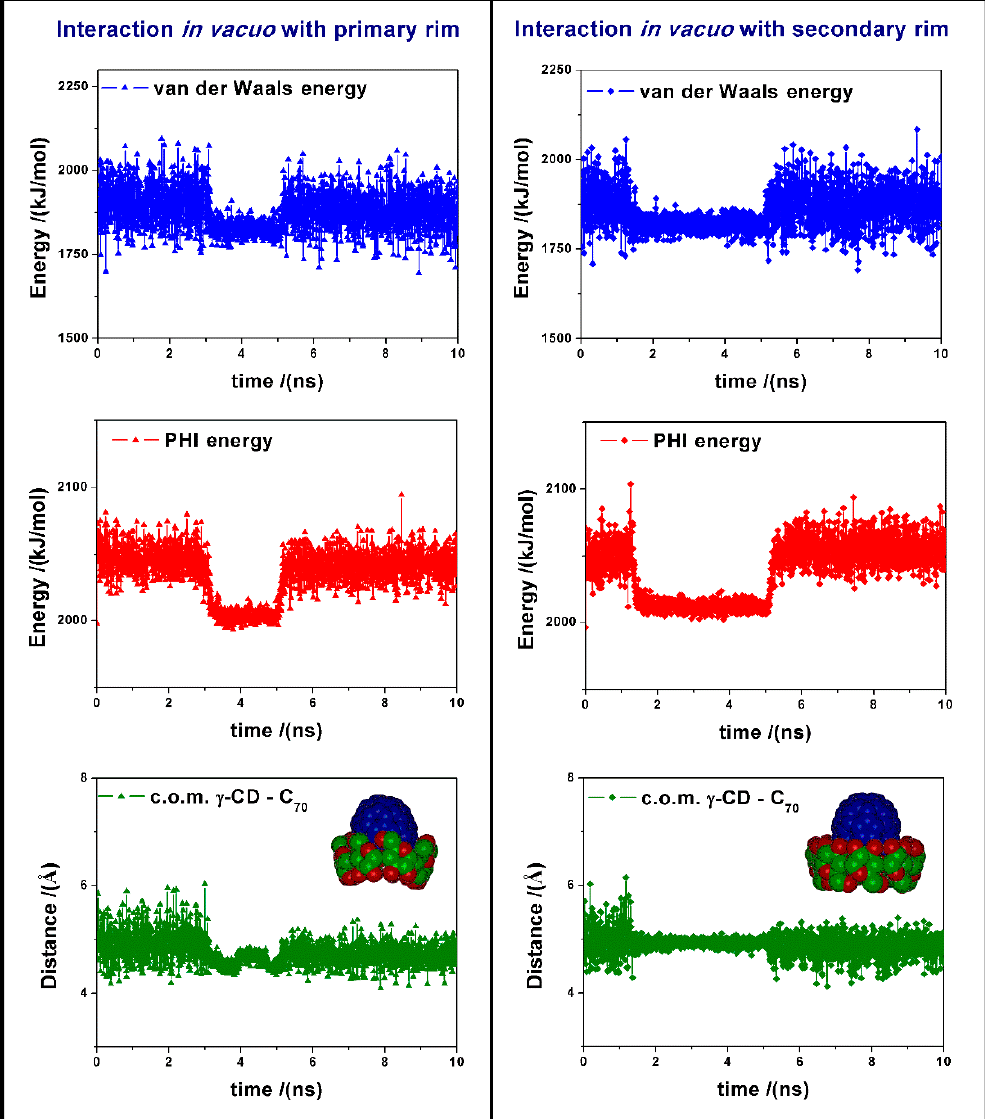
Figure 3. Van der Waals energy, PHI energy variation and distances between the c.o.m of γ -CD, and of C 70 in the 1:1 complex [( γ -CD)/C 70 ] calculated at 300 K as a function of time of MD runs carried out in vacuo for the initial interaction between C 70 and the primary rim at left and for the initial interaction between C 70 and the secondary rim at right.